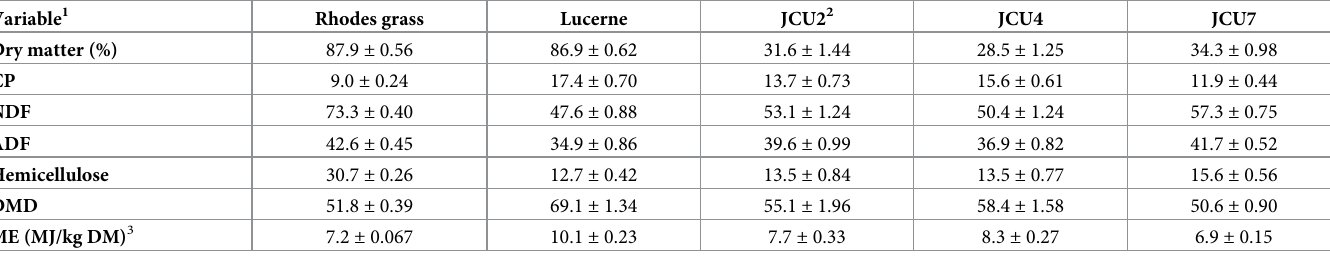
Table 2. Chemical composition (mean ± se) of the experimental diets. Variable 1 Rhodes